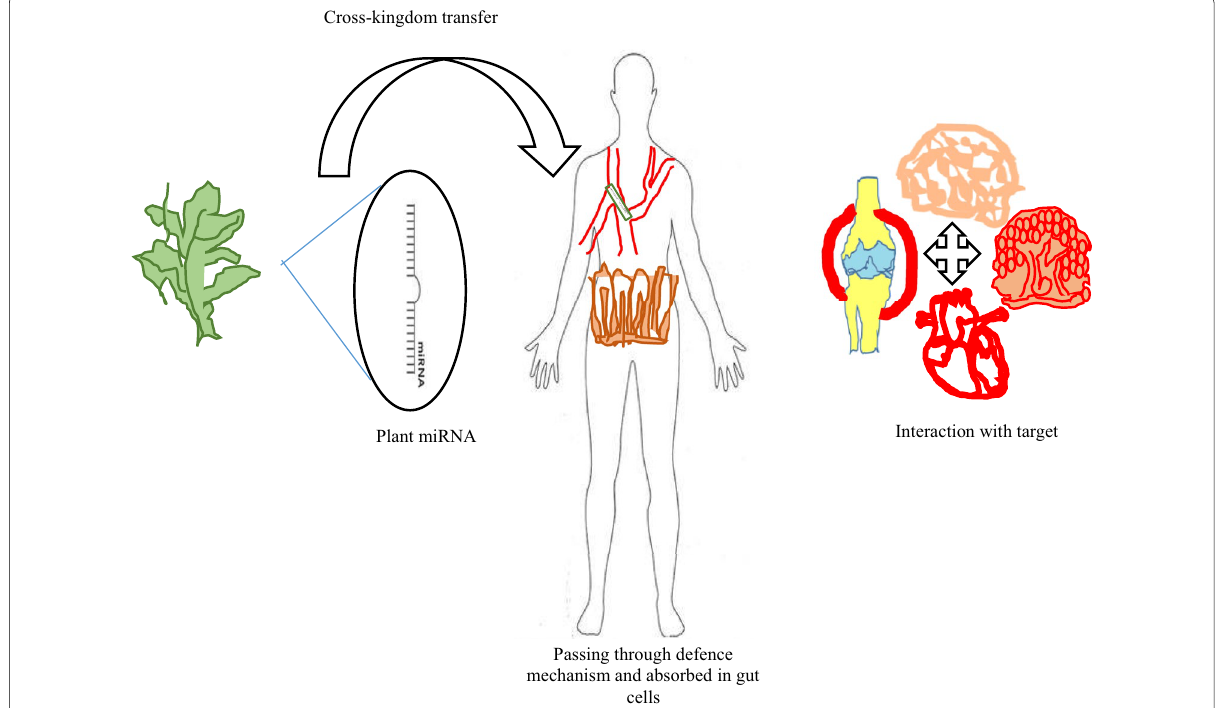
Fig. 3 Plant miRNAs cross-defence mechanisms such as the blood–brain barrier. The RNA transporter protein aids in the absorption of miRNA through gut cells. SID1-2 promotes miRNA uptake and interacts with targets such as (cardiovascular disease, cancer cells, Alzheimer diseases, rheumatoid arthritis and so